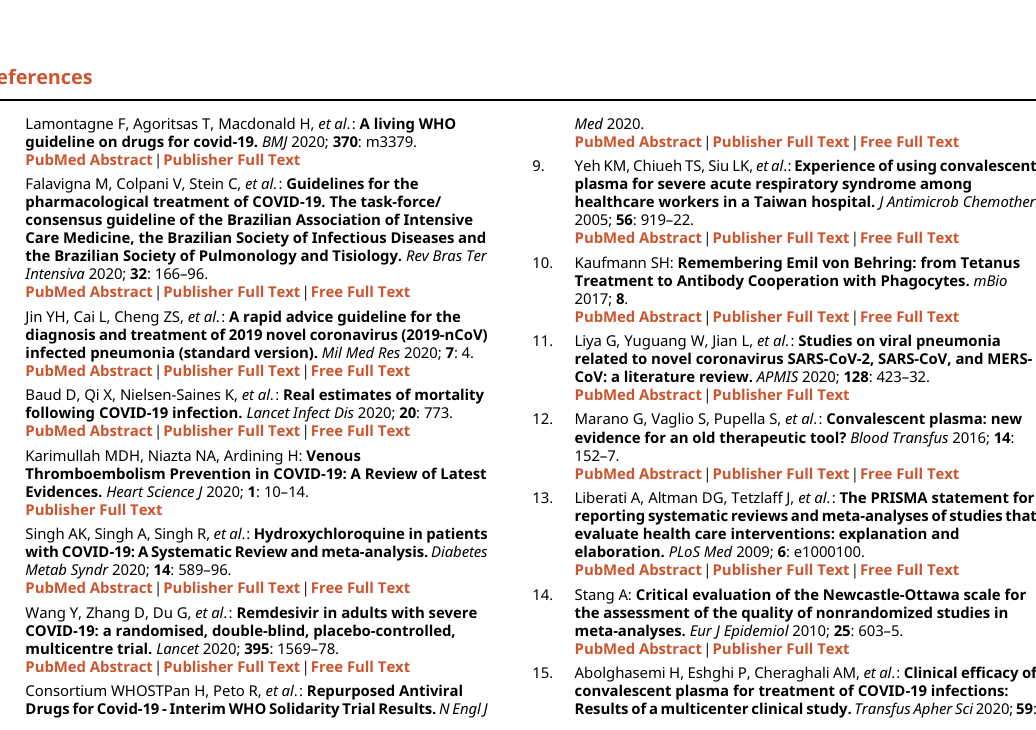
The supplementary file regarding the funnel plot of our study is provided in Figshare (https://doi.org/10.6084/m9. figshare.14046254.v1).